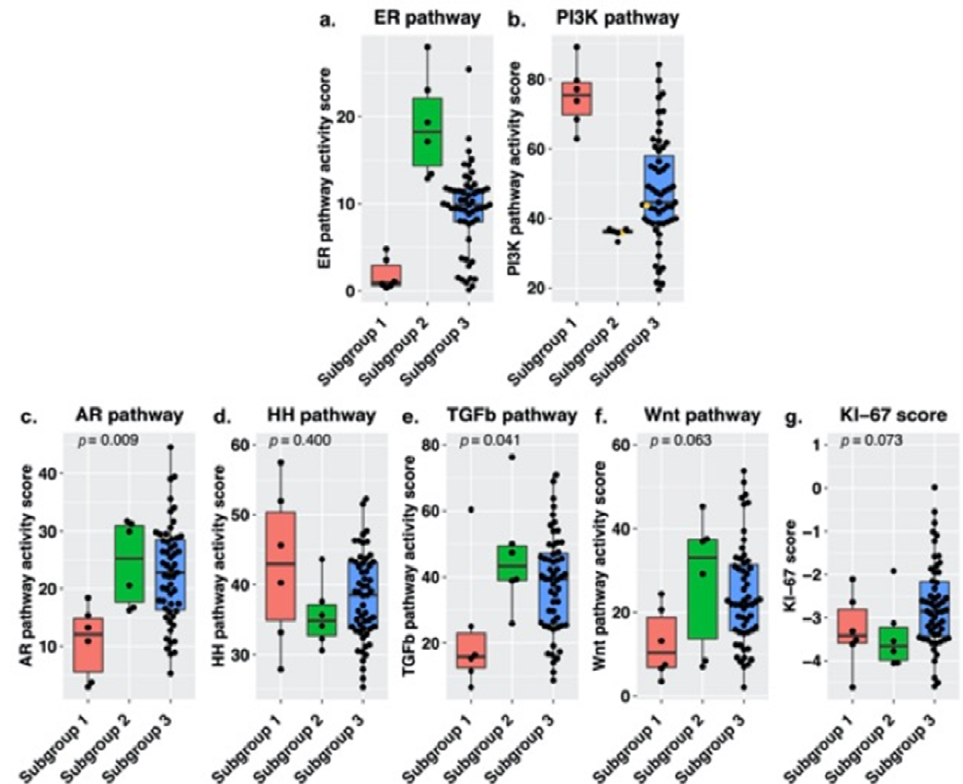
Figure 5. Signal transduction pathway activity measured in the different subgroups containing high- grade serous carcinoma samples of postmenopausal women, for the ( a ) estrogen receptor (ER), ( b ) phosphoinositide-3-kinase (PI3K), ( c ) androgen receptor (AR), ( d ) Hedgehog (HH), ( e ) transforming growth factor beta (TGF- β ) ( f ) canonical wingless-type MMTV integration site (Wnt) pathway and ( g ) KI-67 expression levels. Subgroups were based on ER and PI3K pathway activity. Subgroup 1 ( n = 6) contains samples with low ER pathway activity (quartile 1) and high PI3K pathway activity (quartile 4). Subgroup 2 ( n = 6) contains samples with high ER pathway activity (quartile 4) and low PI3K pathway activity (quartile 1). Subgroup 3 ( n = 55) contains the remaining samples. Median pathway activity was compared among the subgroups, p -values were derived using a Kruskal–Wallis test. The samples with high SOD2 levels are marked in